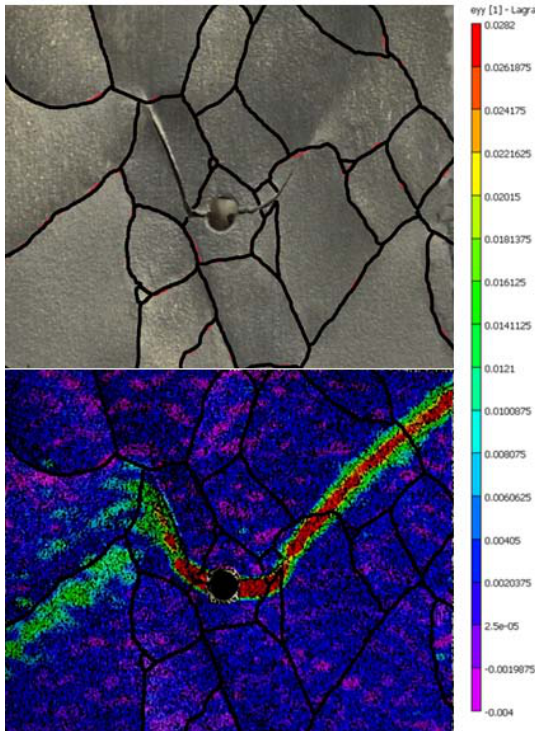
Figure 8: Image of the specimen immediately before plastic collapse. Grain size = 8.22 mm